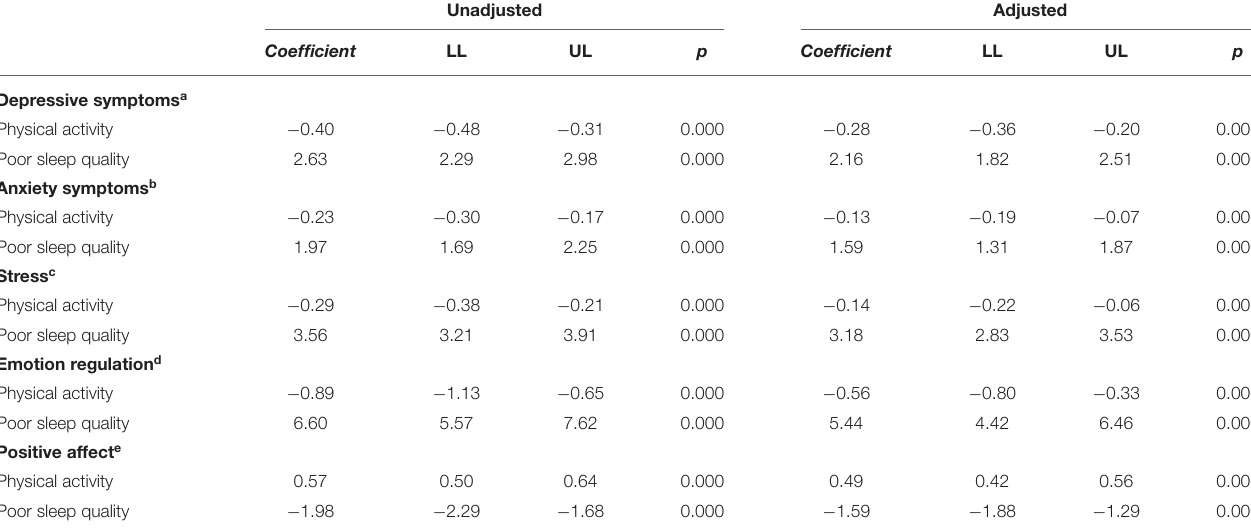
TABLE 5 | Associations between parent movement behaviours (physical activity and sleep quality) and mental health outcomes. Unadjusted Adjusted Coefficient LL UL p Coefficient LL UL